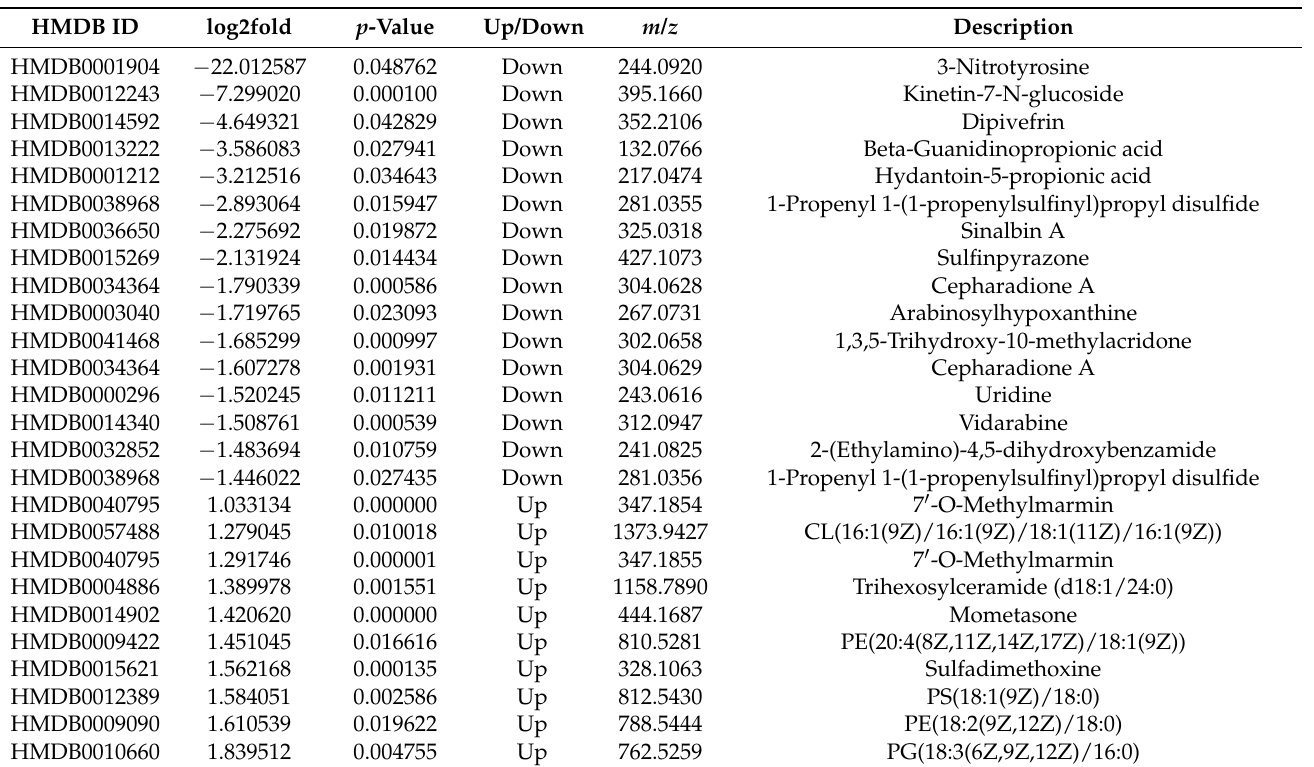
Table 1. List of top differential metabolites found in FFA + DMSO treated group versus FFA + MLN4924 treated group ( p <